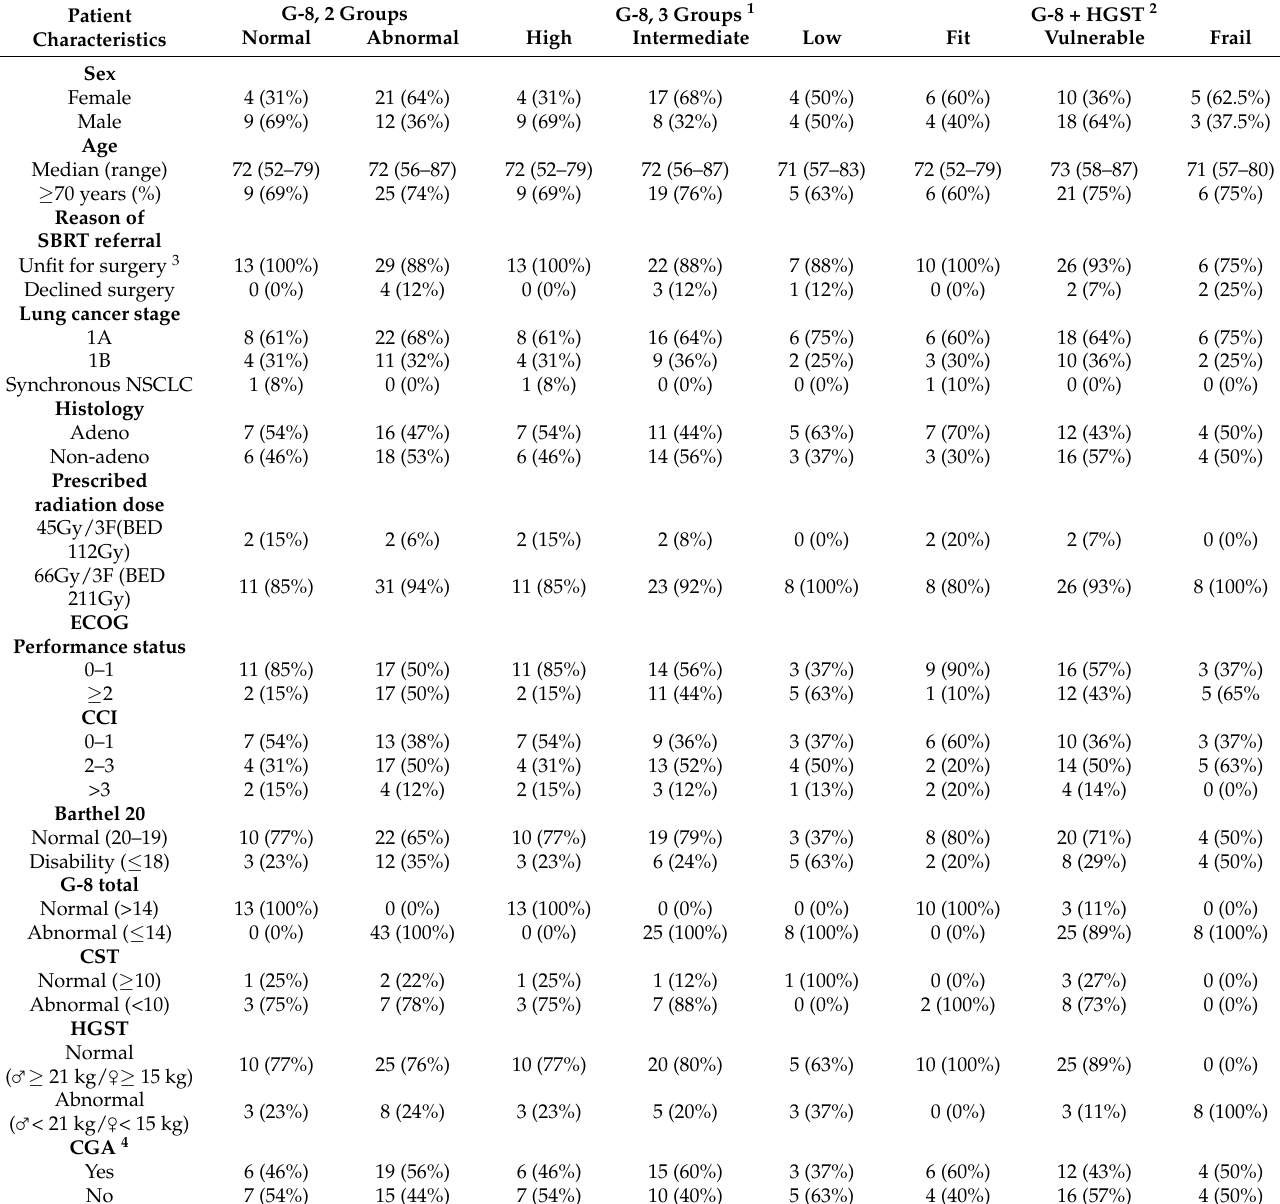
Table A1. Baseline characteristics of patients with localized non-small cell lung cancer who were treated with stereotactic body radiation therapy and divided into three groups: normal vs. abnormal G-8 scores, high vs. intermediate vs. low G-8 scores, and fit vs. vulnerable vs. frail G-8+HGST